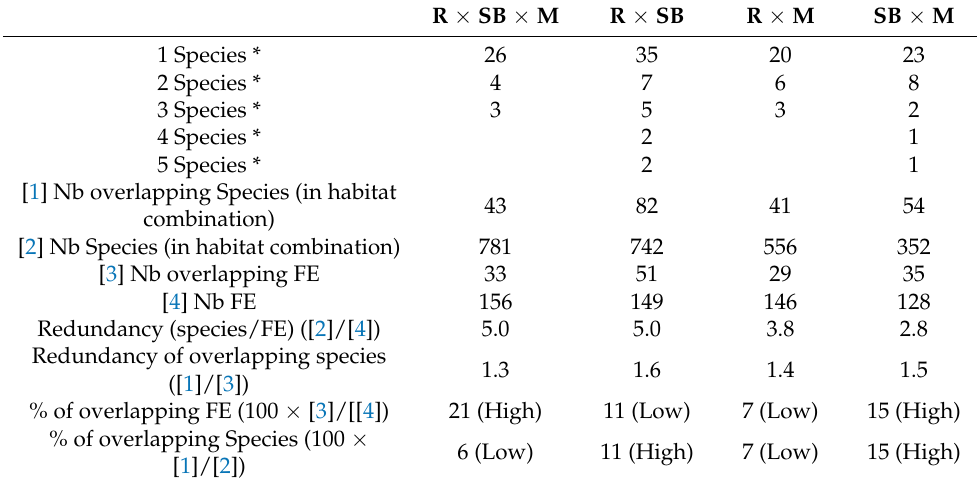
Table 2. Distribution of the diversity of overlapping species amongst functional entities (FE). *: the numbers in the cells represent the number of FE with, respectively, 1 species up to 5 species in common among the habitats. e.g., there are 5 Functional Groups with 3 species in common to both reefs and soft-bottoms. R: Reef; SB: Soft-bottom; M: mangrove—RxSBxM indicates species found in all 3 habitats. It should be noted that here only taxa identified to the species level are